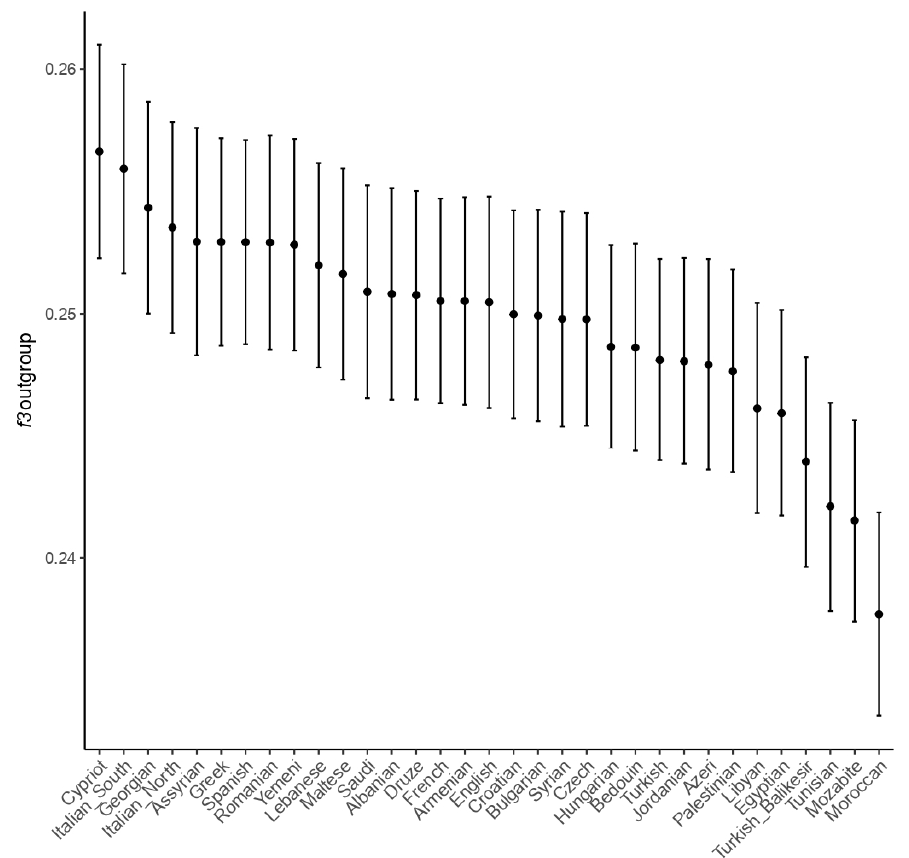
Figure 4. Visual representation of the f3-outgroup statistics for CB and present-day populations in the form of the f3 outgroup (Papuan; CB, populations).